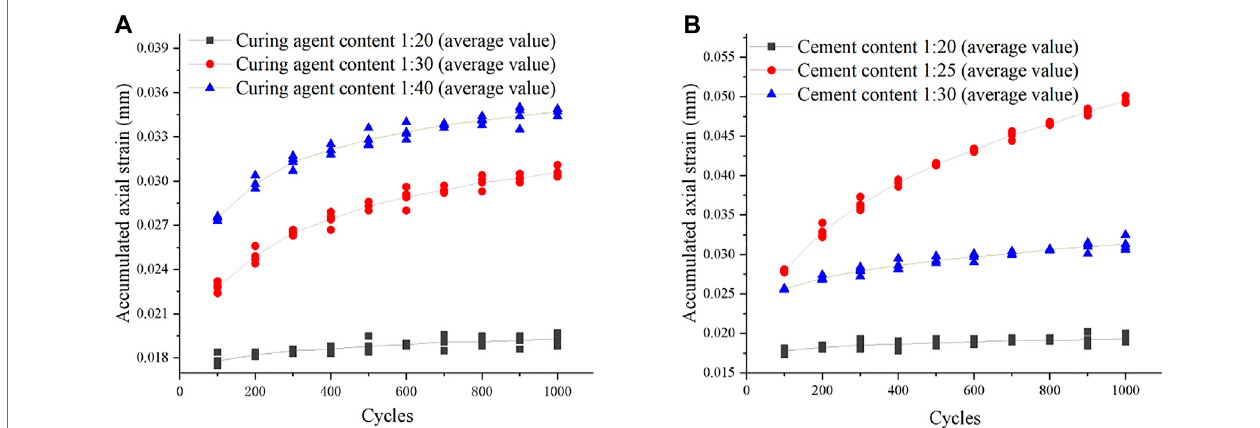
FIGURE 2 | Cumulative strain change curve of sample under dynamic load amplitude N (cid:1) 100N and different cycle times (A) Different curing agent content (B) Different cement